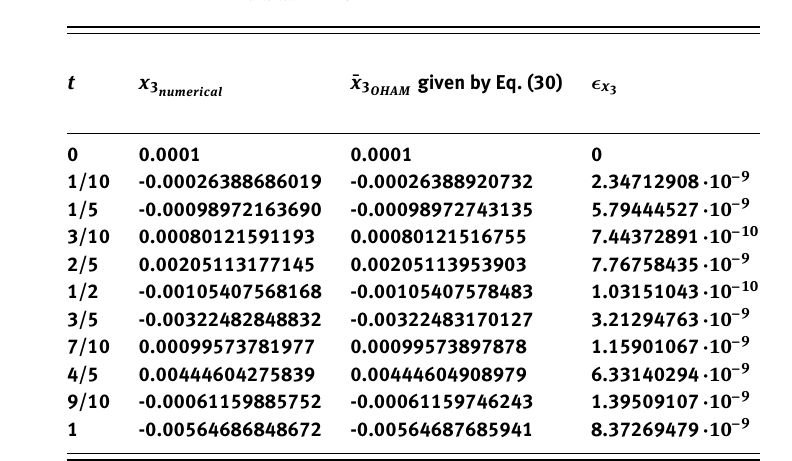
Table 1. The comparison between the approximate solutions ¯ x 3 given by Eq. (30) and the corresponding numerical solutions for M = 15 and P = 20 (relative errors: (cid:15) x